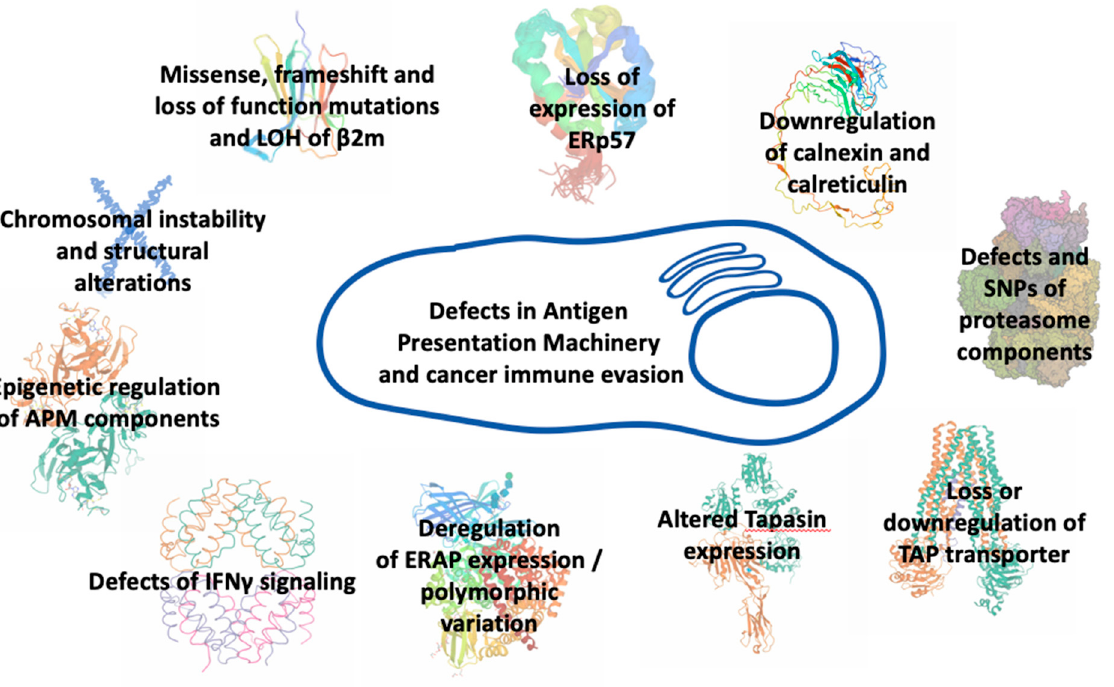
Figure 2. Defects in different components of the antigen processing and presentation machinery that can underlie immune evasion by cancer.